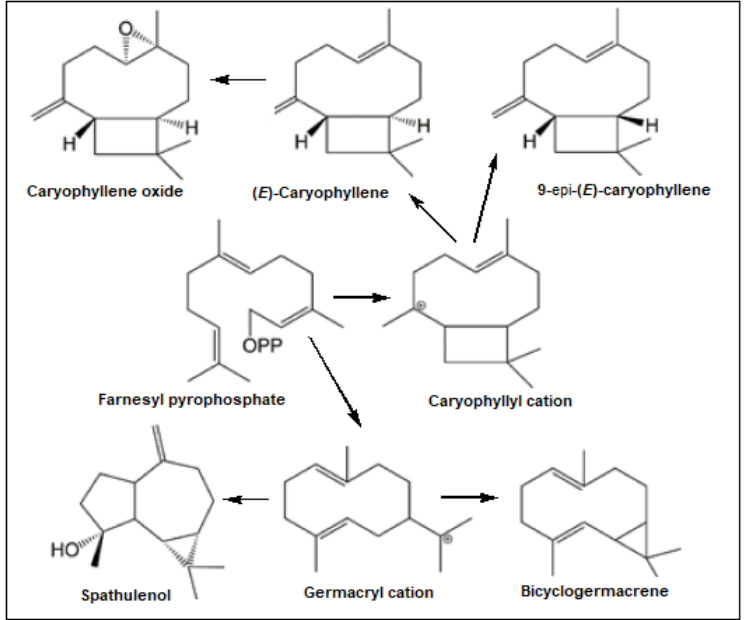
Figure 4. Biosynthetic pathway of the main constituents from E. patrisii essential oil. ( E )-Caryophyllene and caryophyllene oxide have a robust wooden odor, used as cosmetic and food additives. These two natural compounds are approved as flavorings by the Food and Drug Administration (FDA) and European Food Safety Authority (EFSA) and used in a mixture, how they often occur in plants. In medical practice, the application of the mixture of ( E )-caryophyllene and caryophyllene oxide in combination with the classical anticancer drugs could bring significant benefits, potentializing the efficacy of the chemotherapeutics, eliciting the supplementary antineoplastic effect, and reducing the refractory cancer pain, at the same time [12]. It has been seen that among ( E )-caryophyllene and caryophyllene oxide, this letter has more substantial anticancer properties, explained by its chemical structure. The caryophyllene oxide structure contains the functional groups methylene and exocyclic epoxide. Therefore, it can bind covalently to proteins and DNA bases by the sulfhydryl and amino groups. So, caryophyllene oxide has revealed high potential as a signaling modulator for tumor cancer cells